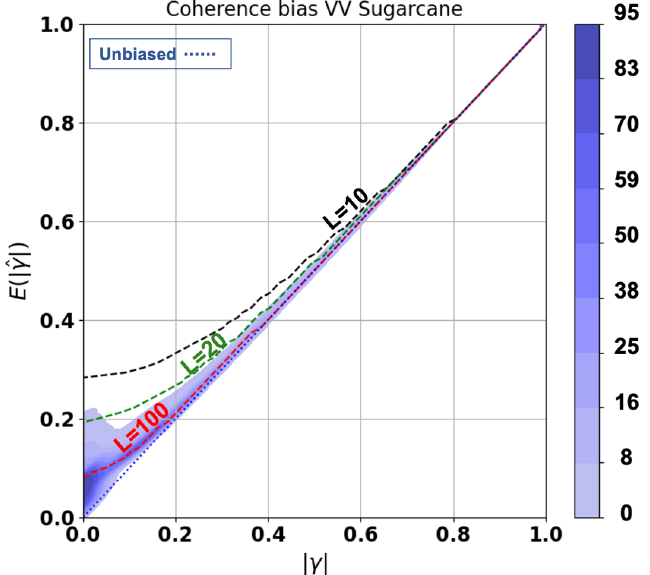
Figure 4. Coherence magnitude bias of sugarcane fields with different number of samples L . The color refers to the number of